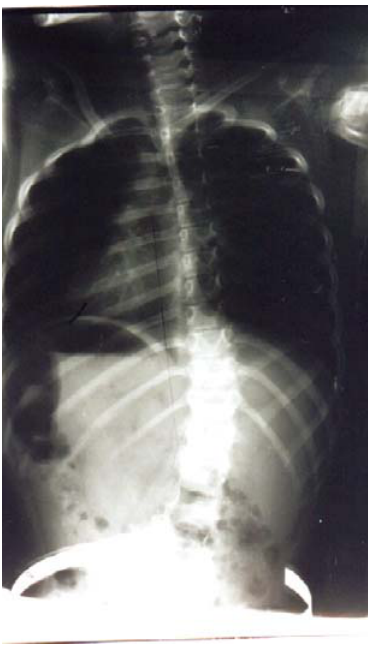
FIGURE 2 . A follow-up X-ray, taken on July 18, 1999, in a suspended position showing 22º Cobb